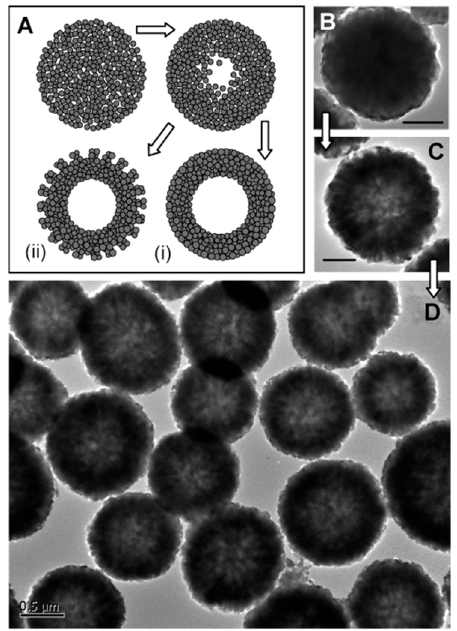
Figure 12. ( A ) Schematic illustration (cross-sectional views) of the ripening process and two types (i and ii) of hollow structures. Evolution (TEM images) of TiO 2 nanospheres synthesized with 30 mL of TiF 4 (1.33 mM) at 180 °C with different reaction times: ( B ) 2 h (scale bar = 200 nm), ( C ) 20 h (scale bar = 200 nm), and ( D ) 50 h (scale bar = 500 nm) [75]. Copyright 2004 American Chemical Society.